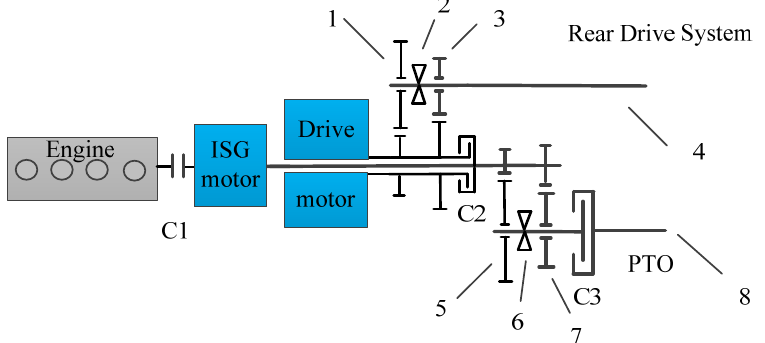
Figure 1. The configuration of the coupled-split power system. (1) Low gear; (2) synchronizer; (3) high gear; (4) rear driveshaft; (5) low gear of PTO; (6) synchronizer; (7) intermediate gear of PTO; (8)